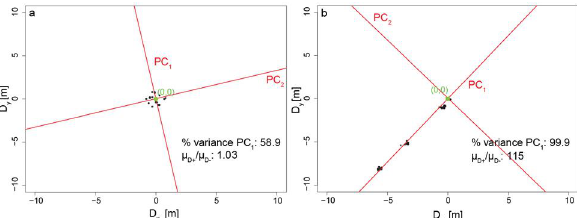
Figure 2. Exemplary result of the fPCA on stable terrain (left) and on an active landslide (right) illustrating the increase